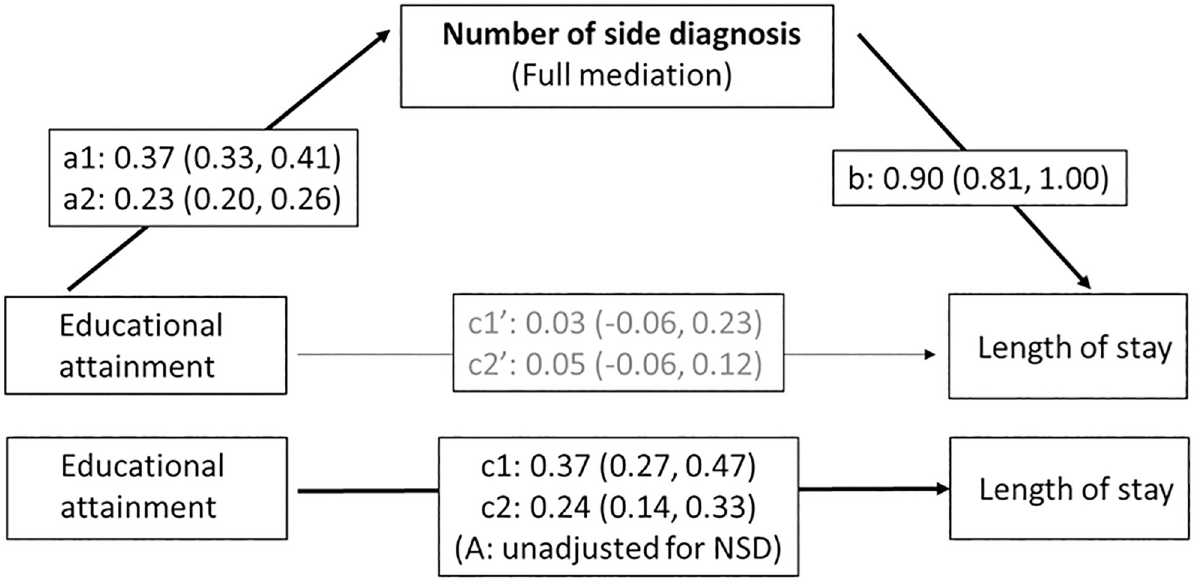
Fig 4. Mediation of the effect of educational attainment on length of stay by the number of side diagnoses (educational attainment: Compulsory = a1, c1, c1’; upper secondary = a2, c2, c2’; tertiary = reference). Indirect effects of educational attainment on length of stay: a1 � b = 0.371 � 0.901 = 0.334 (95% Monte Carlo CI: 0.283, 0.388); a2 � b = 0.229 � 0.901 = 0.206 (0.169, 0.245). Mediation Model with intermediate outcome number of side diagnoses: controlling for clustering on hospital- and on patient-level and adjusted for sex, age, nationality, insurance class, household type, chronic condition, language region of hospital and year of